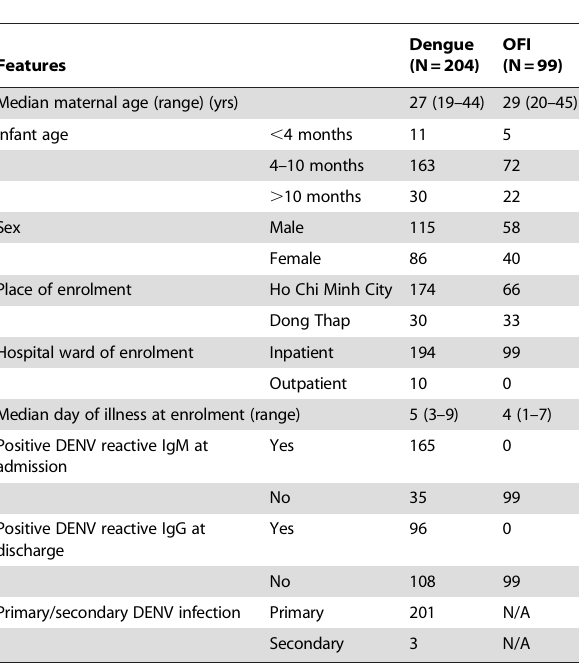
Table 1. Demographic and serological characteristics of study